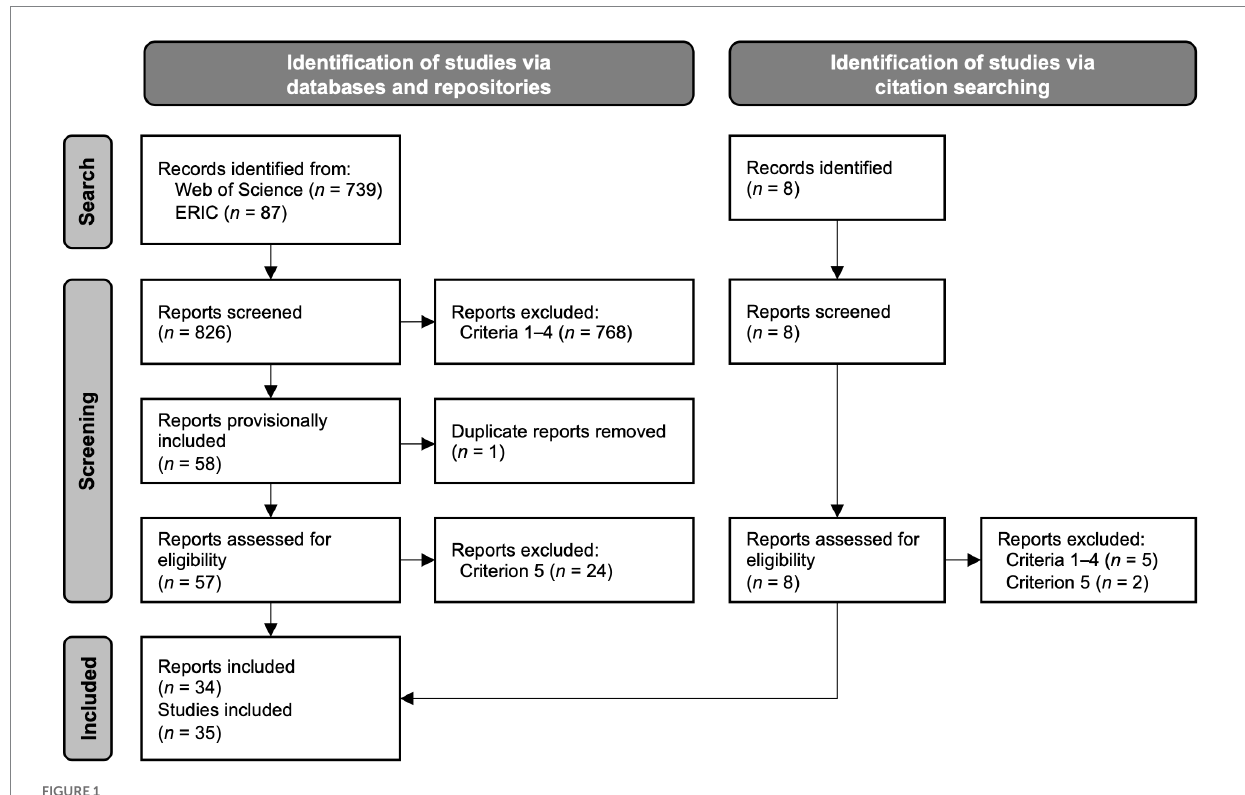
FIGURE 1 PRISMA flow diagram of the study search and selection